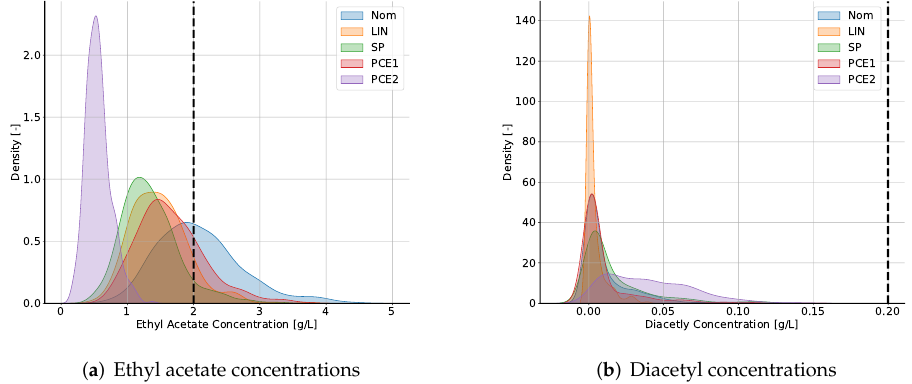
Figure 5. Density plots for concentrations of ethyl acetate and diacetyl based on Monte Carlo simulations for optimal trajectory obtained with maximising ethanol. The vertical dashed line depicts the concentration